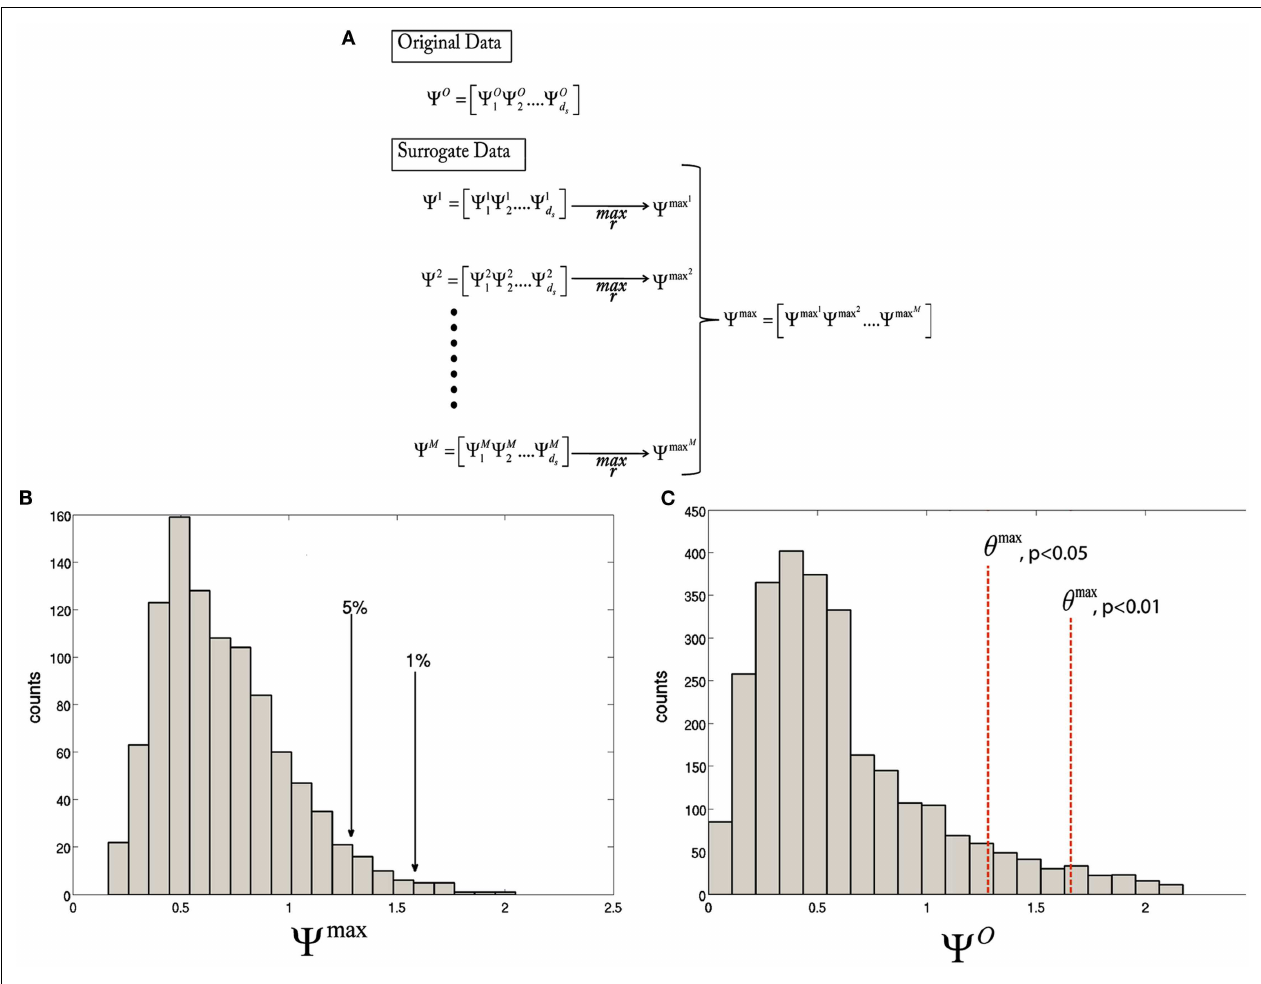
(cid:57) maxm , with arrows pointing to the 1st and 5th percentiles, corresponding to . p < 0.01 and 0.05, respectively. (C) A histogram of the original statistic, (cid:57) O r with the θ max , p < 0.01 and θ max , p < 0.05, corresponding to the values is computed. Finally, the maximum r obtained in (B)